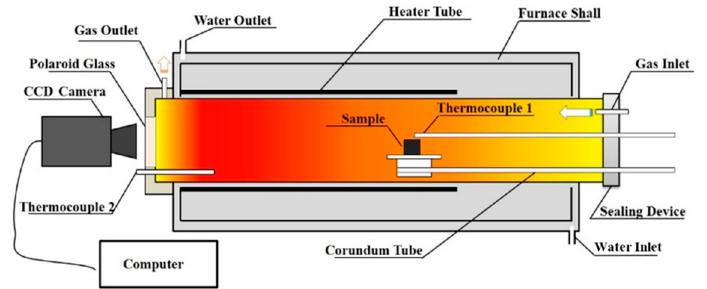
Figure 1. The visible micro-sintering test device.